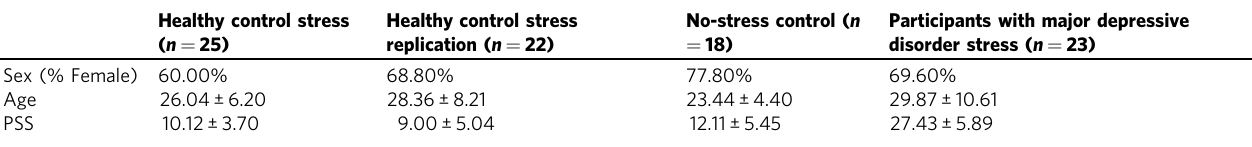
Table 1 Demographics and self-report